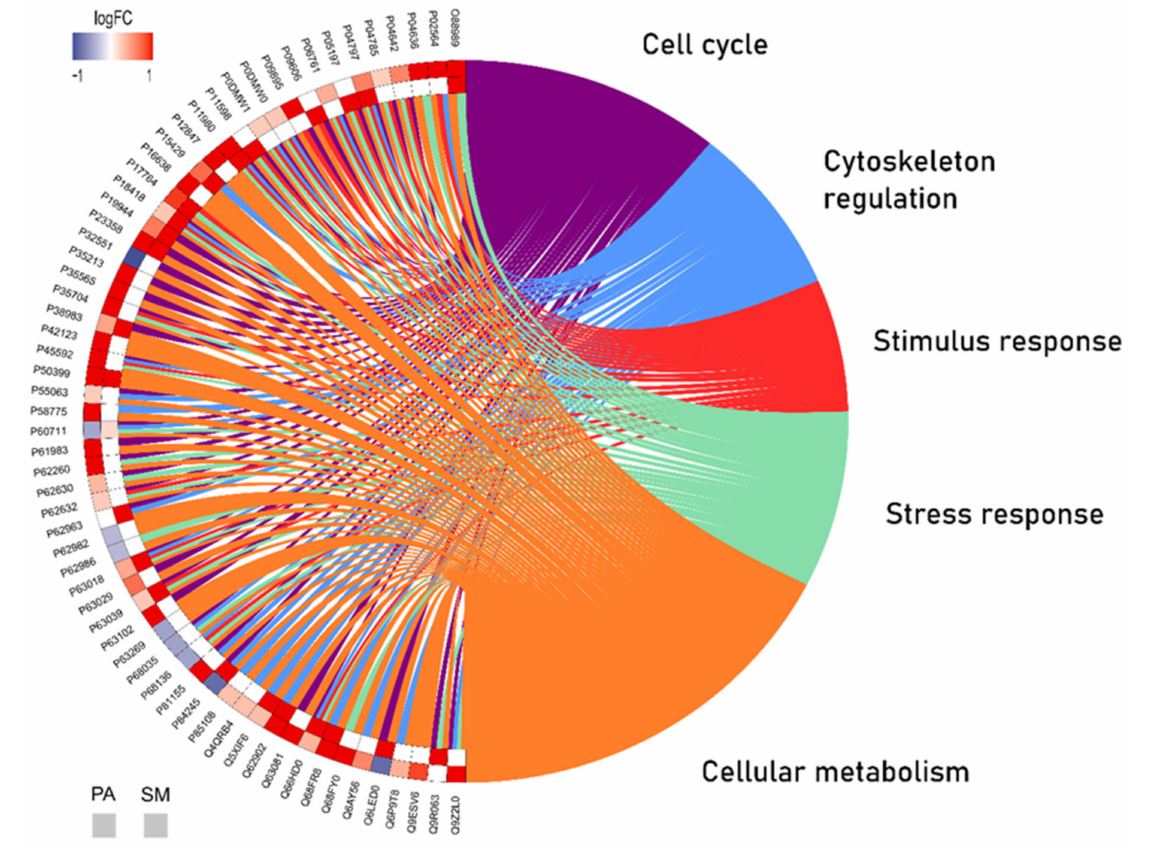
Figure 3. Over-representation analysis (Circos plot) presenting the protein–protein interactions be- tween the aluminum and control groups in both parotid (PA; the outside square) and submandibular (SM; the inner square) glands and the biological processes involved according to Gene Ontology. The altered regulation is expressed according to the colors. Blue represents subexpression, red represents superexpression and white represents